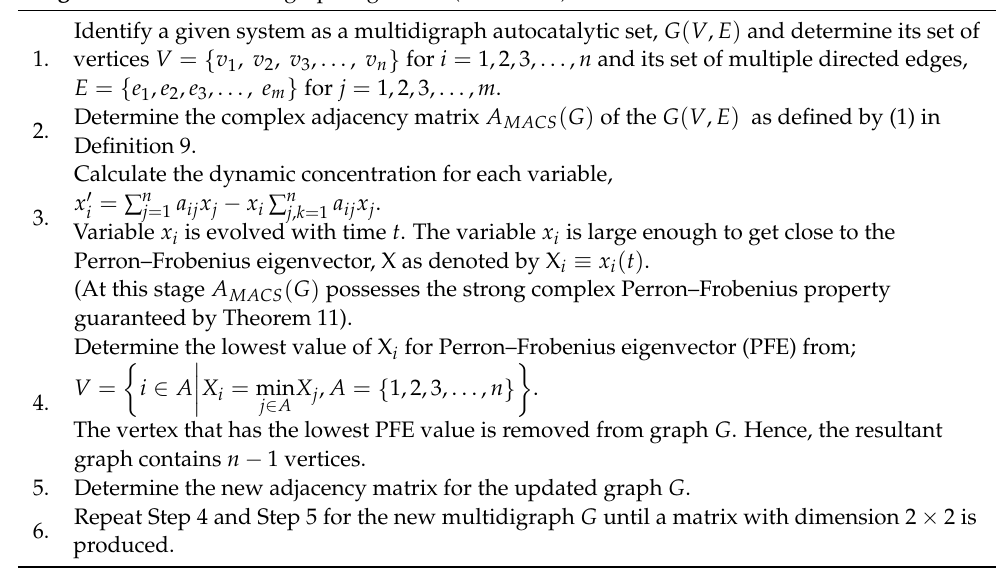
Algorithm 1: The MACS graph algorithm (MACSGA)